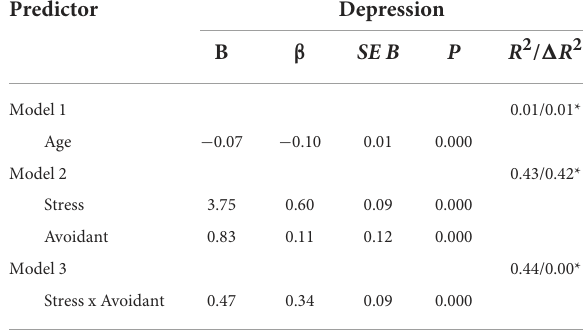
TABLE 4 Regression analysis showing age, stress, and avoidant coping as predictors of depression ( n = 3356). Predictor